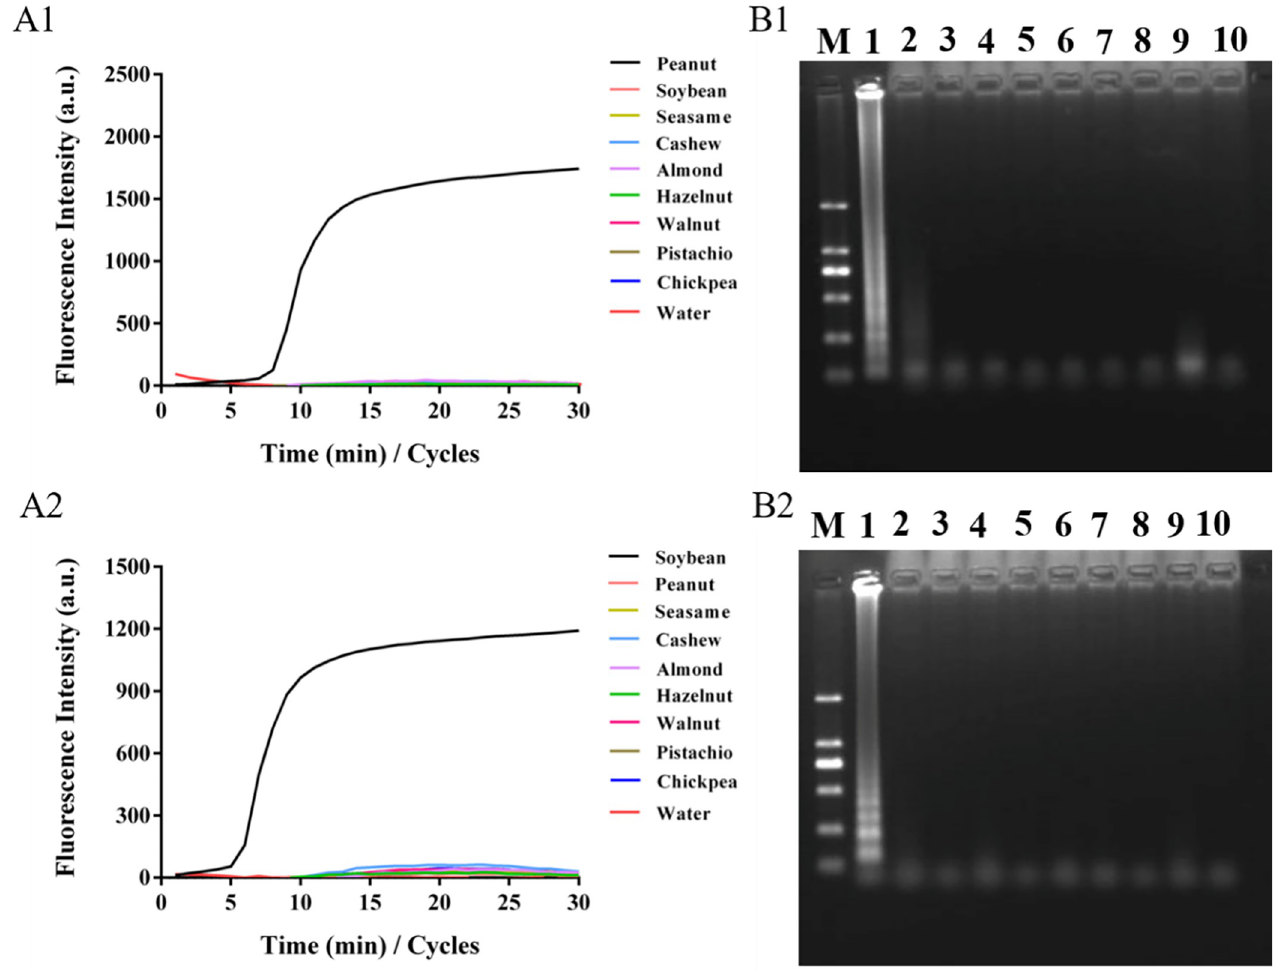
Fig 3. Specificity of LAMP detection with paper-based microfluidics extraction. Notes: A1 & A2, LAMP amplification of peanut and soybean; B1 & B2, corresponding ladder electrophoresis bands of peanut and soybean.